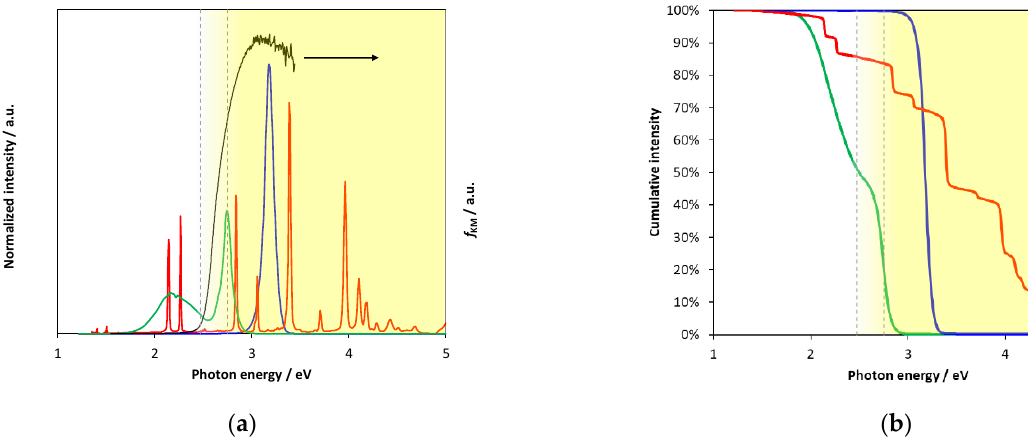
Figure 12. Normalized ( a ) and cumulative ( b ) intensity of the light sources applied for illumination (blue line: UV-LED, red: Hg-Xe arc lamp, green: vis LED). The emission spectra as functions of wavelength are also shown in the SM (Figure S4). The solid black line represent the KM-function, while the gray dashed lines indicate the intermediate energy range where the absorption steeply increases from the band gap for the Cat-2N catalyst. The yellow background symbolizes the light absorbed by the photocatalyst.